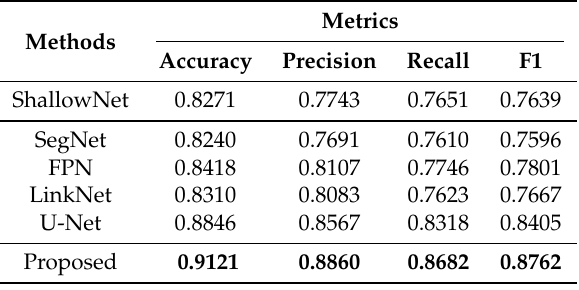
Table 6. Numerical Results for all architectures in the whole configuration, that means three dates and dual polarisation.